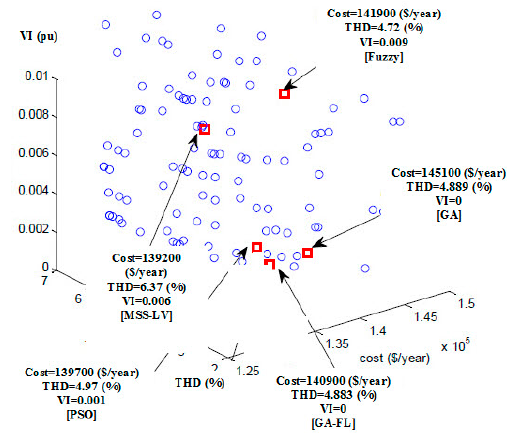
Figure 3. Curve of the proposed method with three objectives: cost, total harmonic distortion (THD) and voltage index (VI).